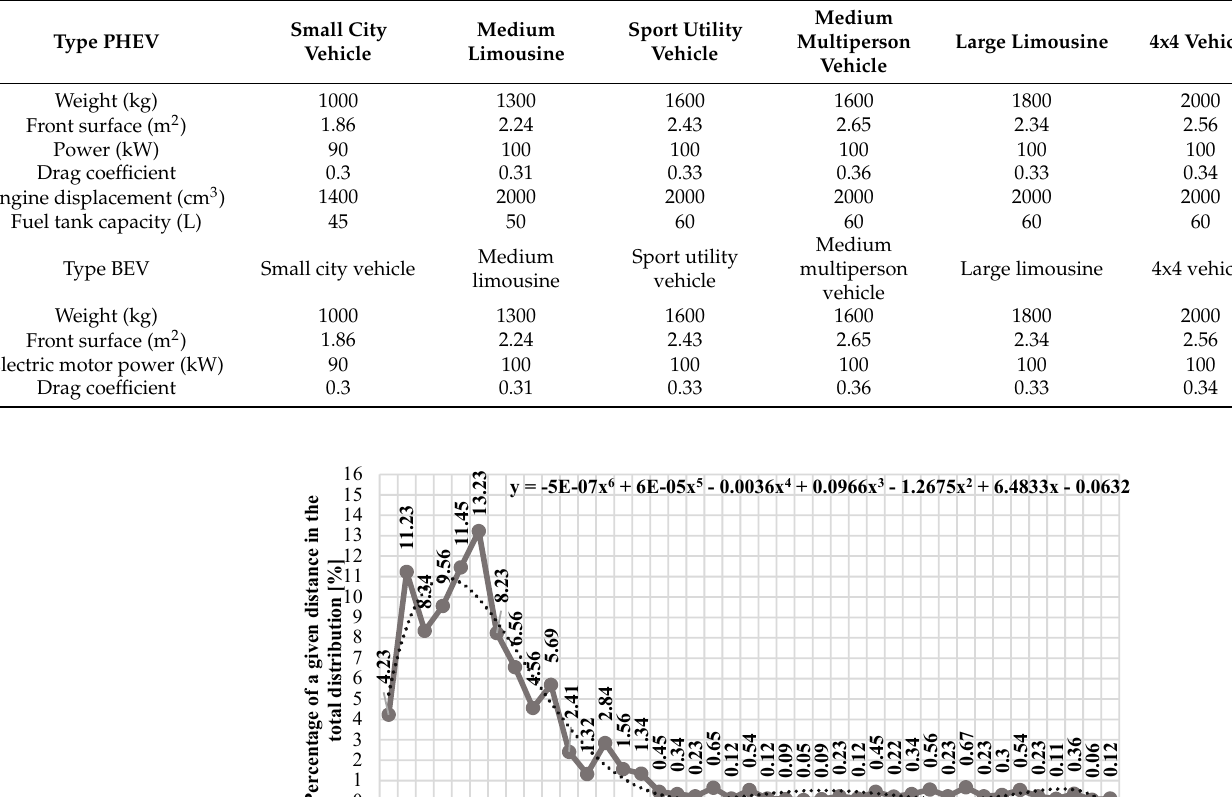
Table 1. Characteristics of PHEVs and BEVs.